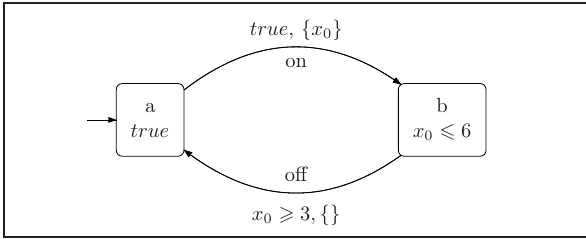
Figure 1. The simple light switch.